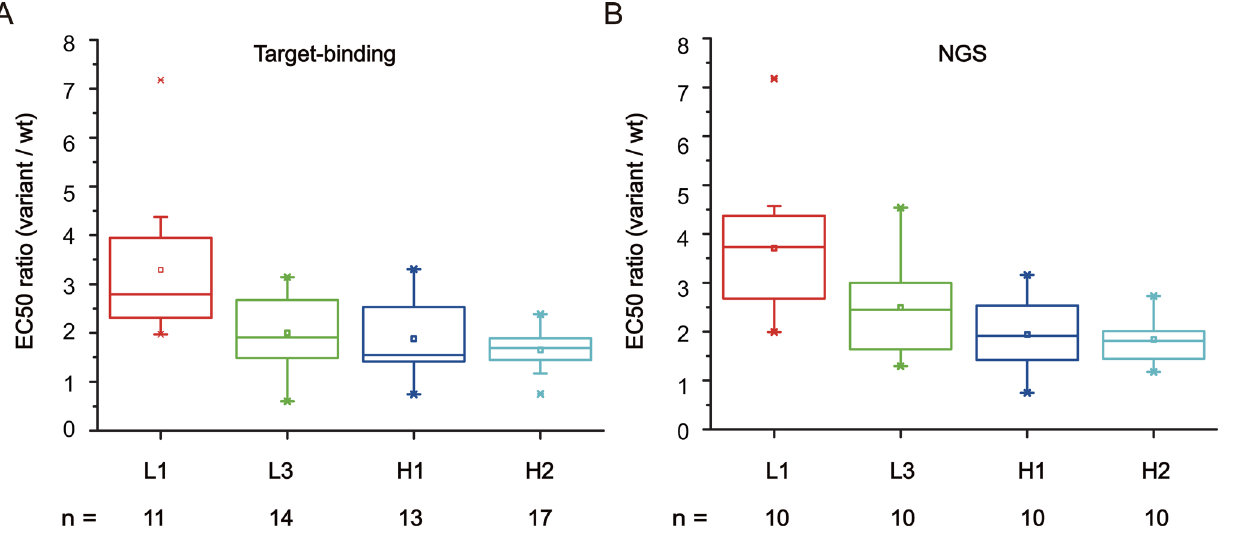
Fig 4. Affinity gains by target-binding screening and NGS approaches. The scFv-Fc mutants were expressed in Expi293 cells to determine their apparent binding affinities to ErbB2 by screening ELISA. The fold affinity enhancement was calculated as the EC50 ratio of wild-type HuA21/mutant. The numbers of mutants from different CDR libraries are